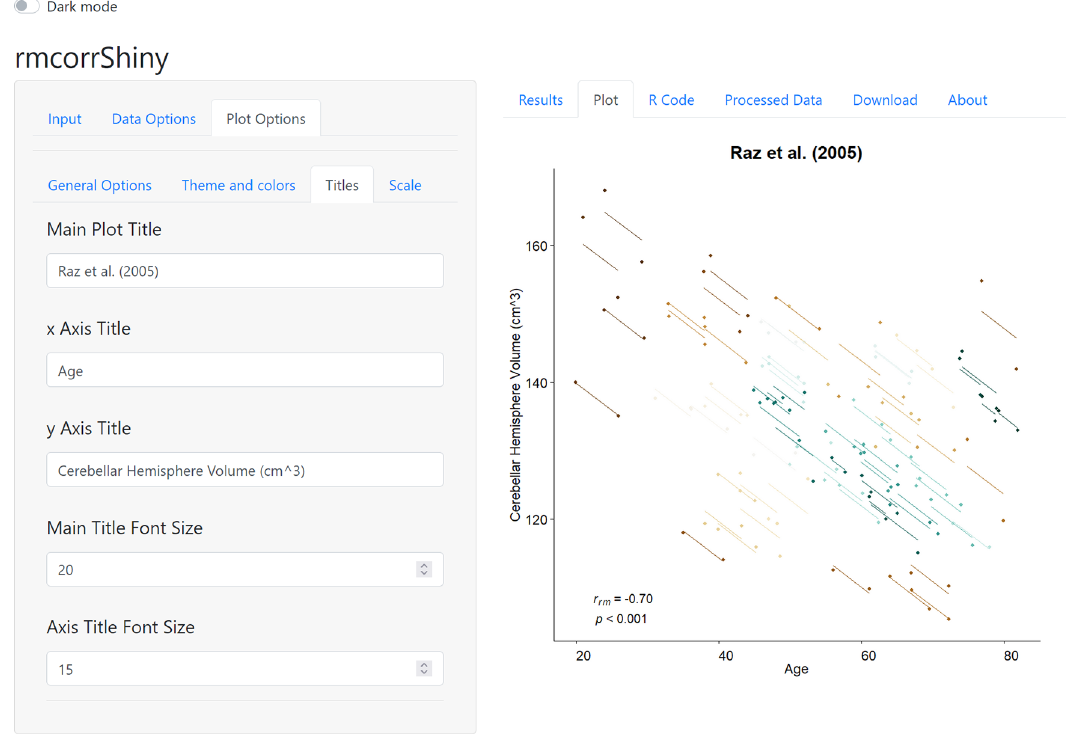
Figure 2. Plot options and rmcorr plot of sample neuroscience dataset raz2005.